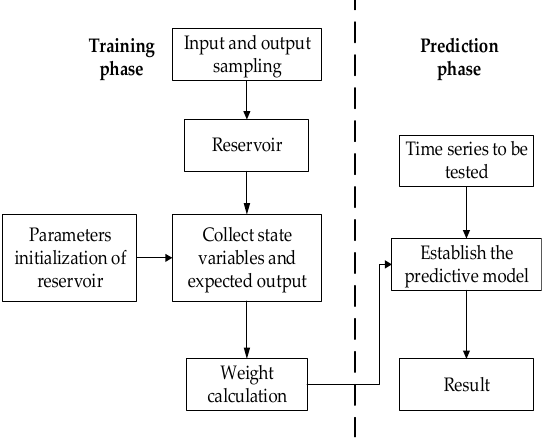
Figure 3. The predictive process of echo state network (ESN).